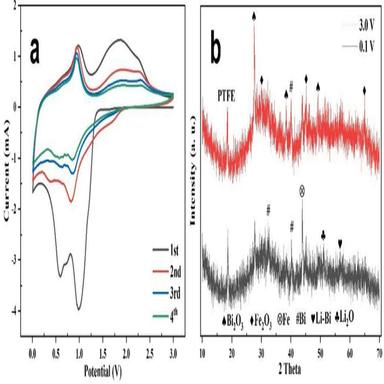
SM-BFO electrode: (a) the first four CV curves at 0.1 mV s−1 and (b) ex-situ XRD patterns discharge to 0.01 V and charged to 3.0 V after 500 cycles at 0.2 A g−1.